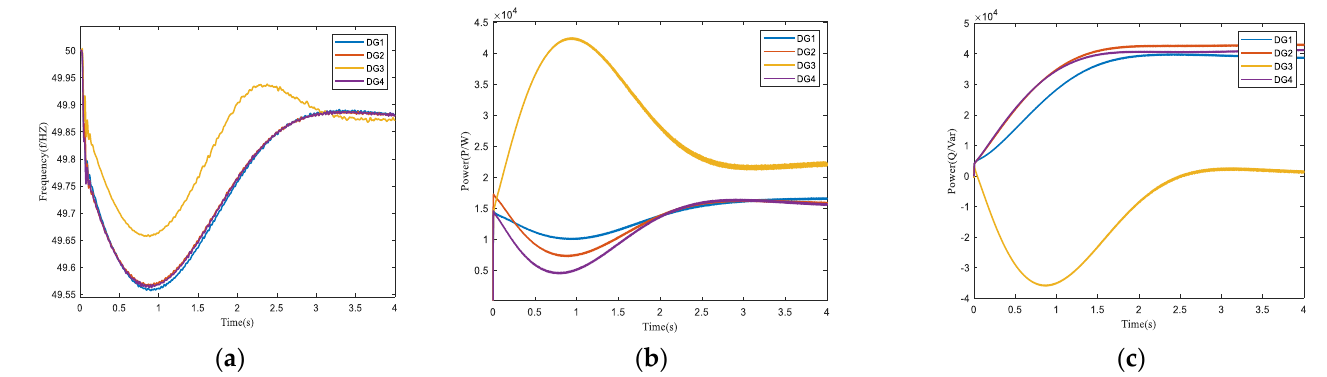
Figure 15. Variation of microgrid secondary control access load parameters ( a ) System access load frequency variation ( b ) Variation of active power of system access load ( c ) Variation in reactive power of system access loads.